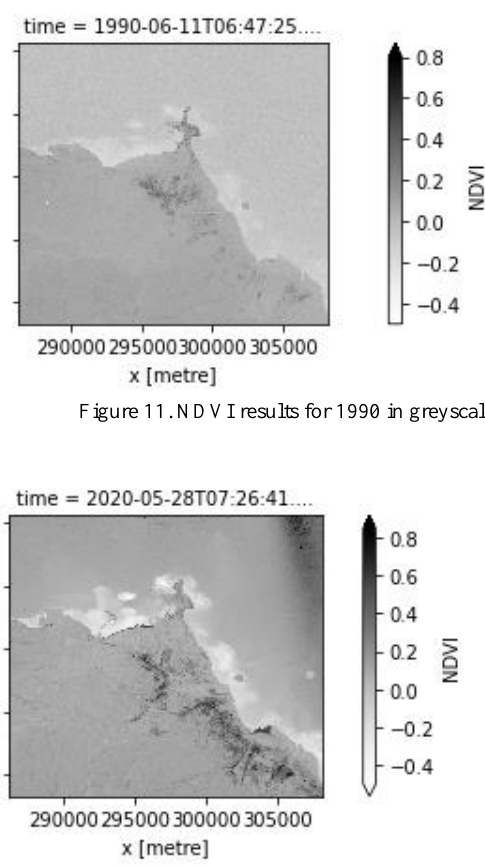
Figure 12. NDVI results for 2020 in